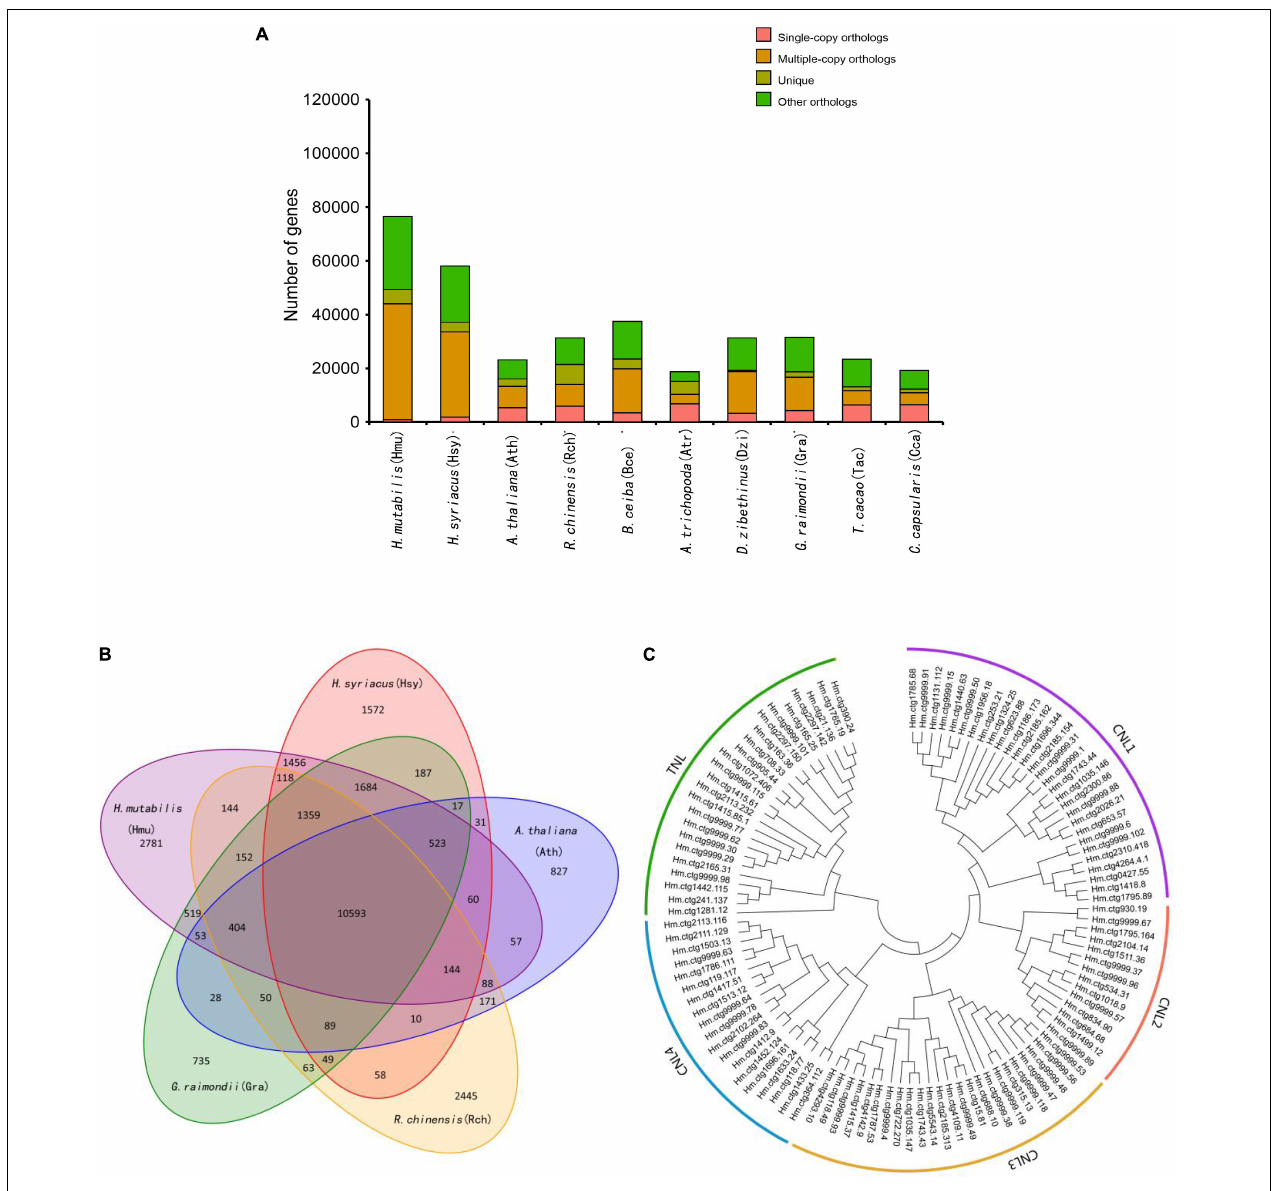
FIGURE 4 | Comparative genomics and evolution of gene numbers. (A) The number of genes in cluster of ten plant species, showing a high gene number in H. mutabilis compared with the model plant A. thaliana and other angiosperm species. The number of multiple-copy paralogs is high in H. mutabilis . (B) Venn diagram showing the numbers of shared gene families among H. mutabilis (Hmu), A. thaliana (Ath), H. syriacus (Hsy), R. chinensis (Rch), and G. raimondii (Gra). (C) Phylogenetic relationships of NBS genes in H. mutabilis